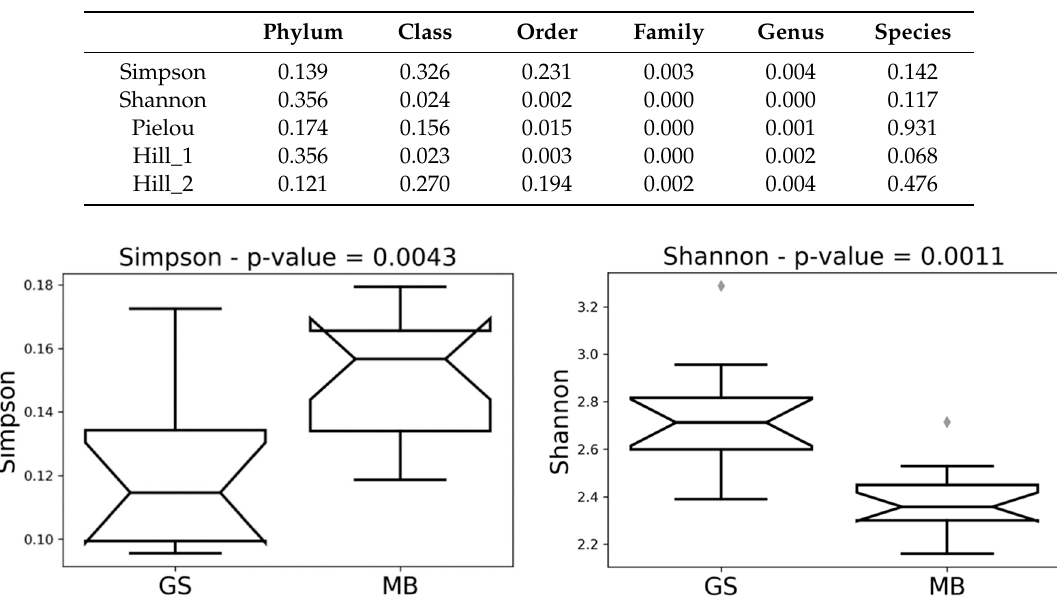
Table 7. p values of alpha diversity calculated by di ff erent indexes in the tested groups at di ff erent taxonomic levels. p values in bold are those significantly di ff